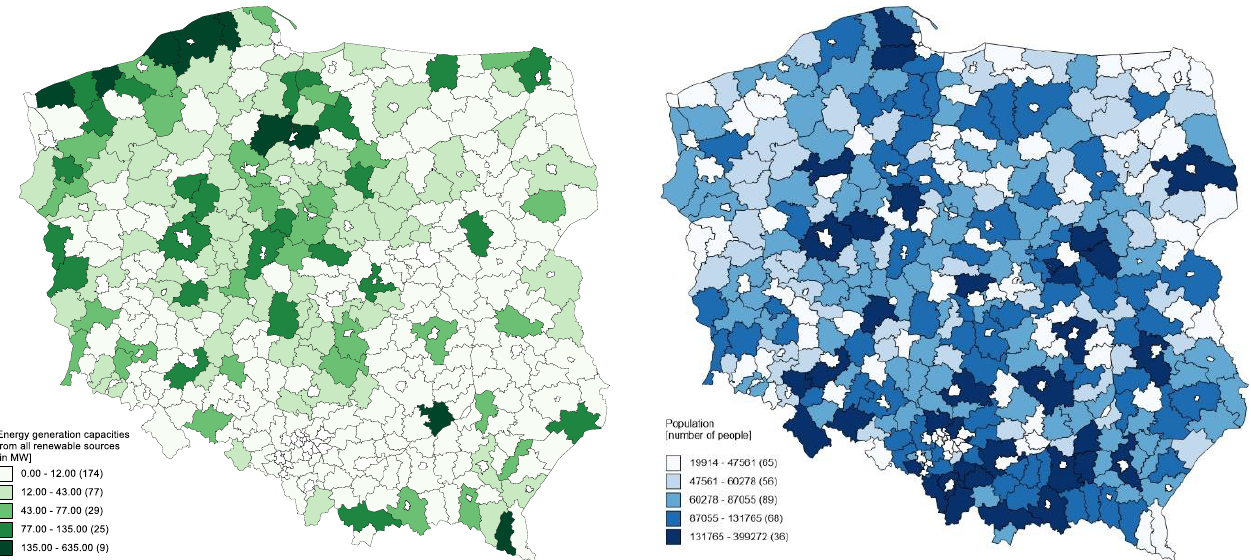
Figure 7. Renewable energy generation capacity of all installation types combined ( left ) and population ( right ) in districts of Poland in 2020. Source: own calculations and presentation.